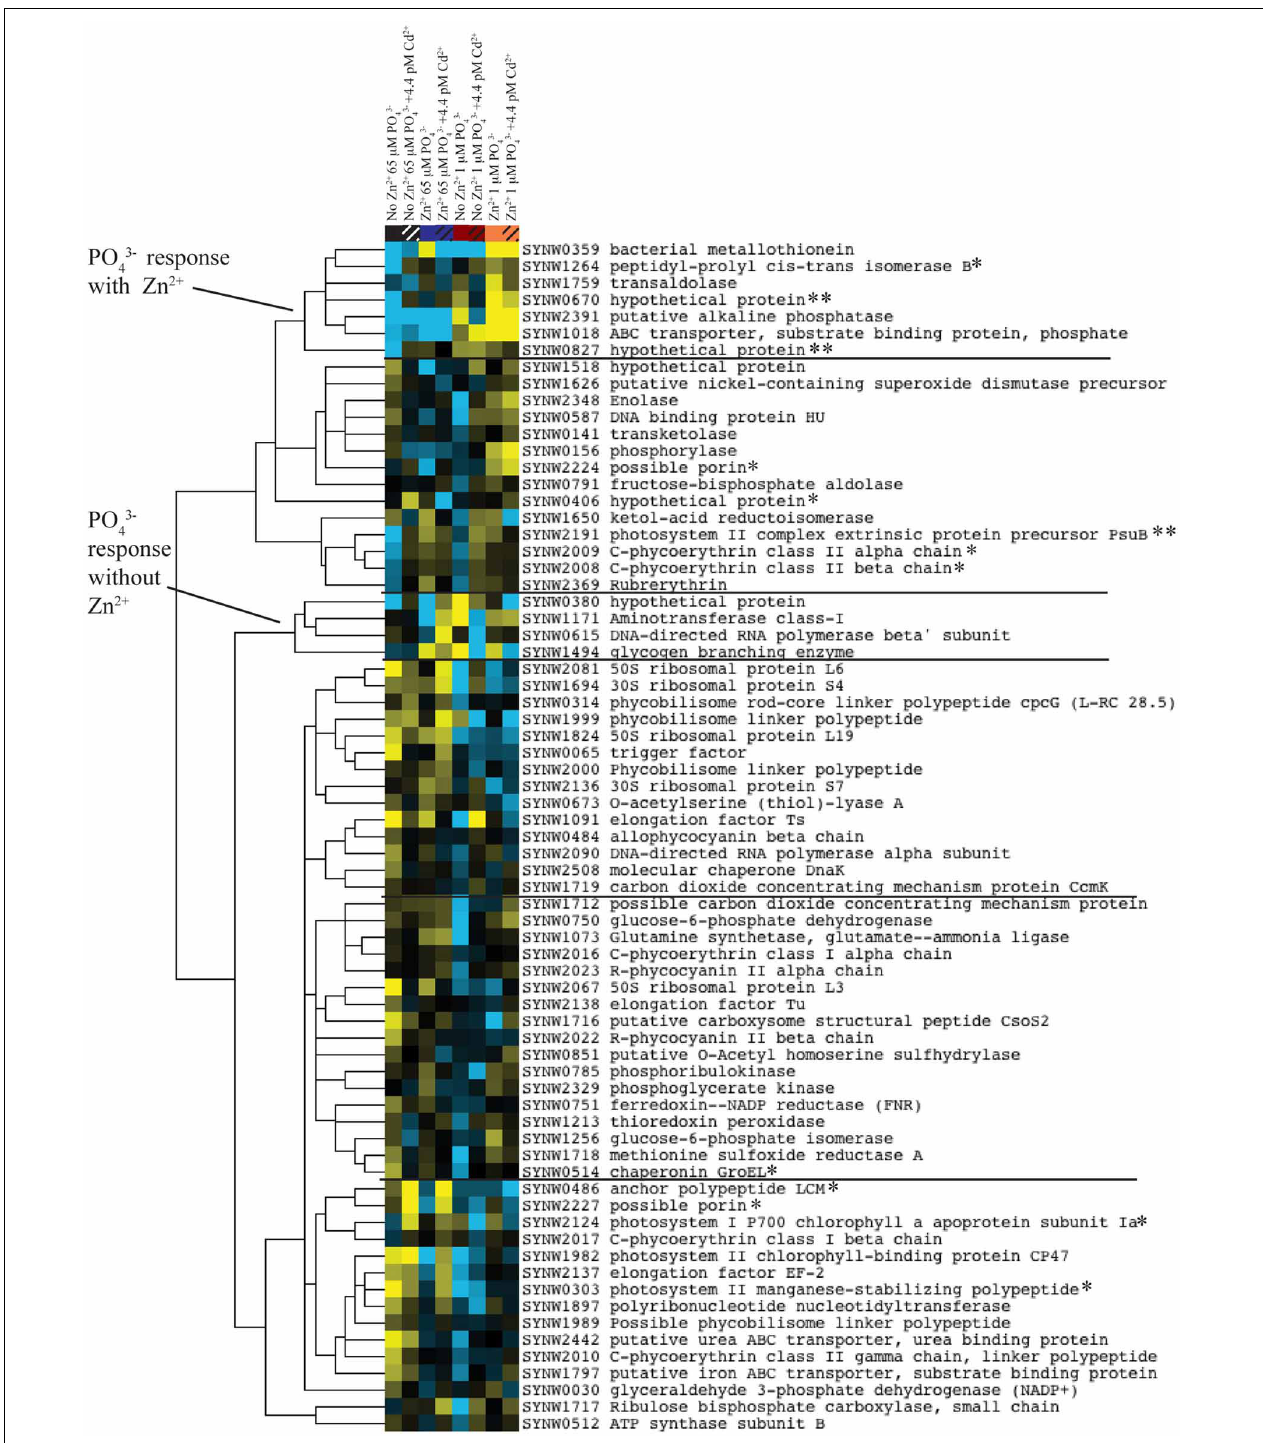
FIGURE 4 | Cluster analysis of relative protein abundances. no Zn/65 μ M PO 43 − , Zn/65 μ M PO 43 − , no Zn/1 μ M PO 43 − , Zn/1 μ M PO 43 − and these four chronic treatments with short term 4.4 pM Cd 2 + added. The four low PO 43 − treatments are on the right and replete, and high PO 43 − on the left. There are 71 proteins. Protein relative abundances are averages of duplicates, have at least 7 counts, and are different by a value